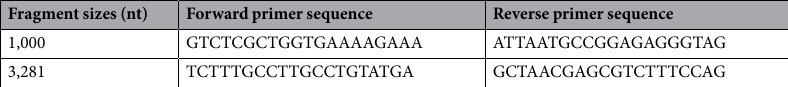
Table 1. Primers used to investigate aPCR synthesis